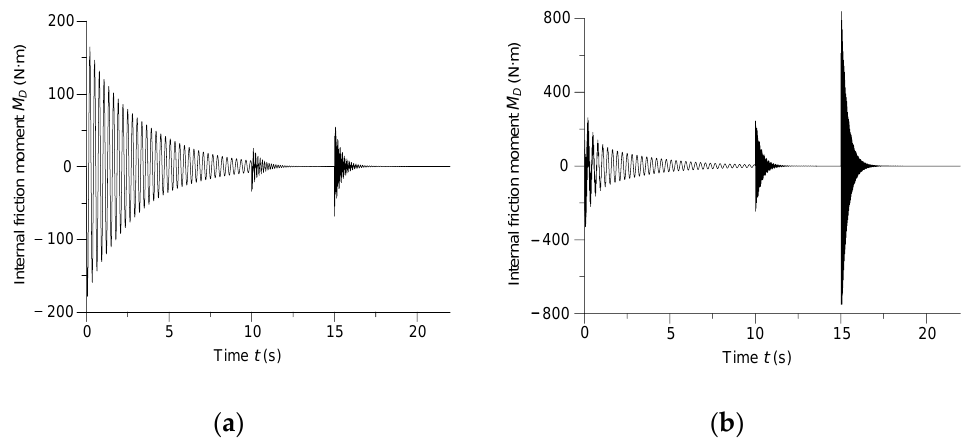
Figure 11. Instantaneous internal friction moment in the: ( a ) second shaft and ( b ) fourth shaft of the ship’s motion transmission.